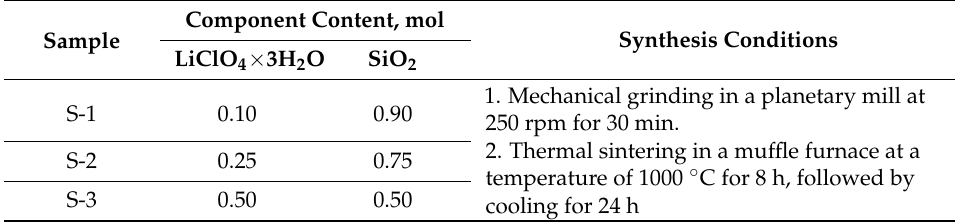
Table 1. Data of experiments on obtaining lithium-containing